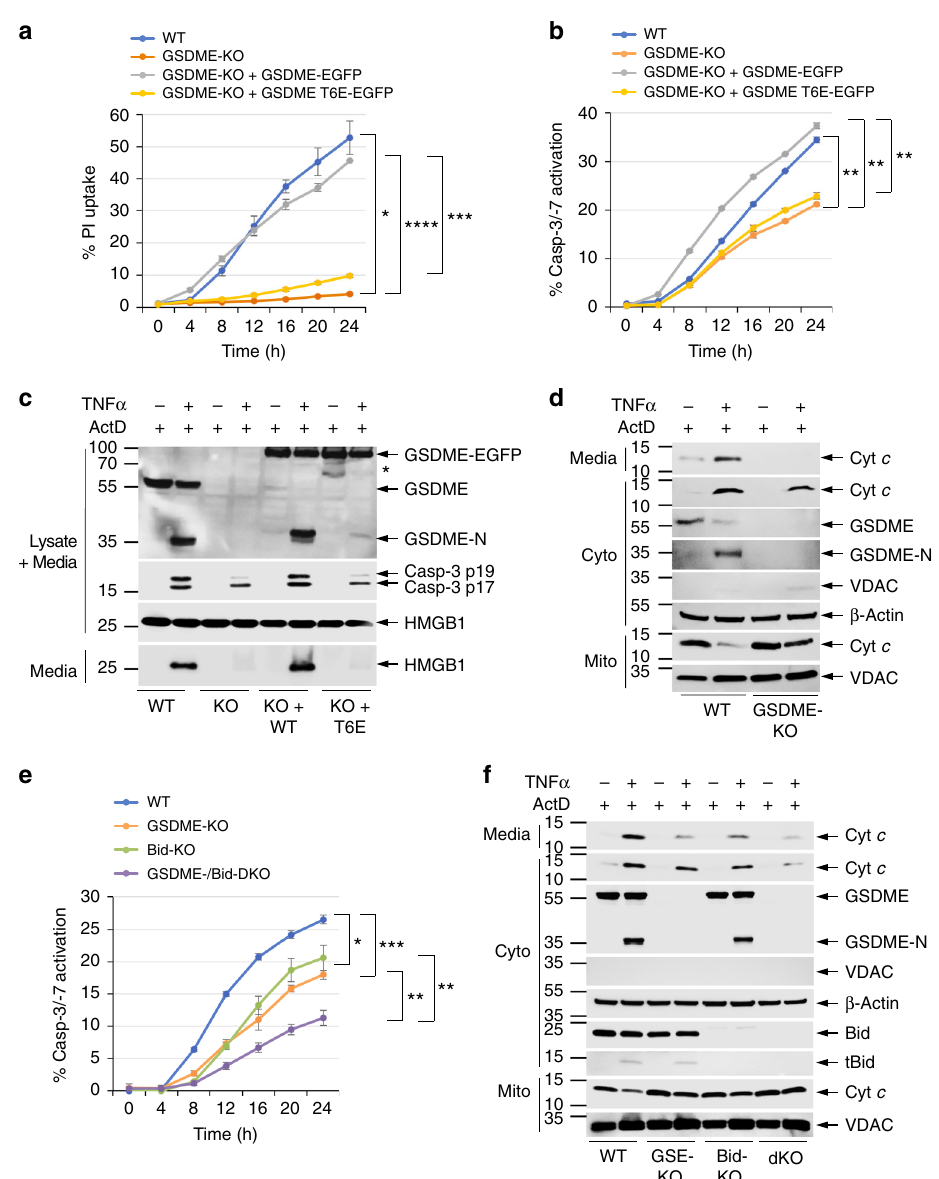
Fig. 6 GSDME augments death receptor-induced pyroptosis and caspase-3 activation. a , b Propidium iodide (PI) uptake ( a ) and active caspase-3/ 7 staining ( b ) in CEM-C7 cells (wild-type (WT), GSDME-knockout (KO), or GSDME-KO reconstituted with WT GSDME-EGFP or GSDME-T6E-EGFP) treated with tumor necrosis factor α (TNF α ) plus actinomycin D (ActD) as measured on the IncuCyte over time. c Immunoblots of GSDME, active caspase- 3 p17/p19, and high-mobility group box 1 (HMGB1) in combined cell lysates plus media, or HMGB1 released in culture media (media) of WT (WT), GSDME-KO (KO), or GSDME-KO reconstituted with WT GSDME-EGFP (KO + WT) or GSDME-T6E-EGFP (KO + T6E) CEM-C7 cells treated with TNF α plus ActD as indicated. d Immunoblots of cytochrome c (Cyt c ) (1st and 2nd panels) released into the culture media (media) or cytosol (Cyto) from WT (WT) or GSDME-KO (KO) CEM-C7 cells treated with TNF α plus ActD for 18 h. e Active caspase-3/7 staining in WT, GSDME-KO, Bid-KO, or GSDME/Bid-dKO CEM-C7 cells treated with TNF α plus ActD as measured on the IncuCyte over time. f Immunoblots of Cyt c (1st and 2nd panels) released into the culture media (media) or cytosol (Cyto) from WT, GSDME-KO (GSE-KO), Bid-KO, or GSDME/Bid-dKO (dKO) CEM-C7 cells treated with TNF α plus ActD. Quantitative analyses of Cyt c release in ( d , f ) are shown in Supplementary Fig. 17. Results are representative of at least three independent experiments performed in duplicate or triplicate. Error bars represent S.D. Student ’ s t -test, * p < 0.05, ** p < 0.005, *** p < 0.0005, **** p <